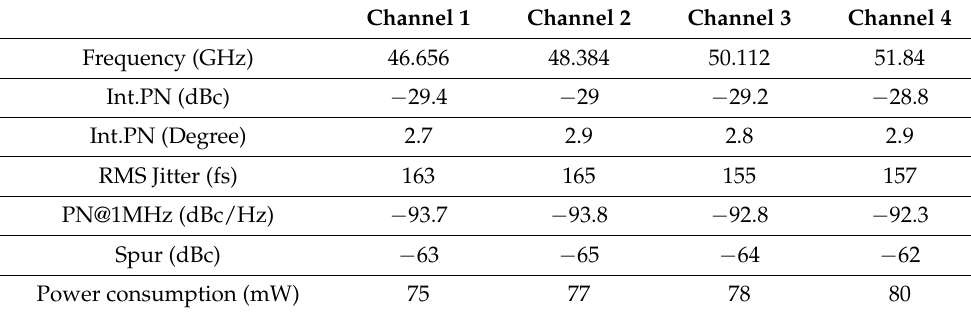
Figure 18. Measured reference clock spurious of the PLL: ( a ) 46.656 GHz; ( b ) 48.384 GHz; ( c ) 50.112 GHz; ( d ) 51.840 GHz. Table 3 summarizes the measured PLL results at four channels of the 60 GHz bands. The power consumption of the PLL is about 80 mW. The integrated phase noise and RMS jitter are about − 29 dBc and 155 fs, respectively. Table 3. PLL measurement results at four channels of the 60 GHz